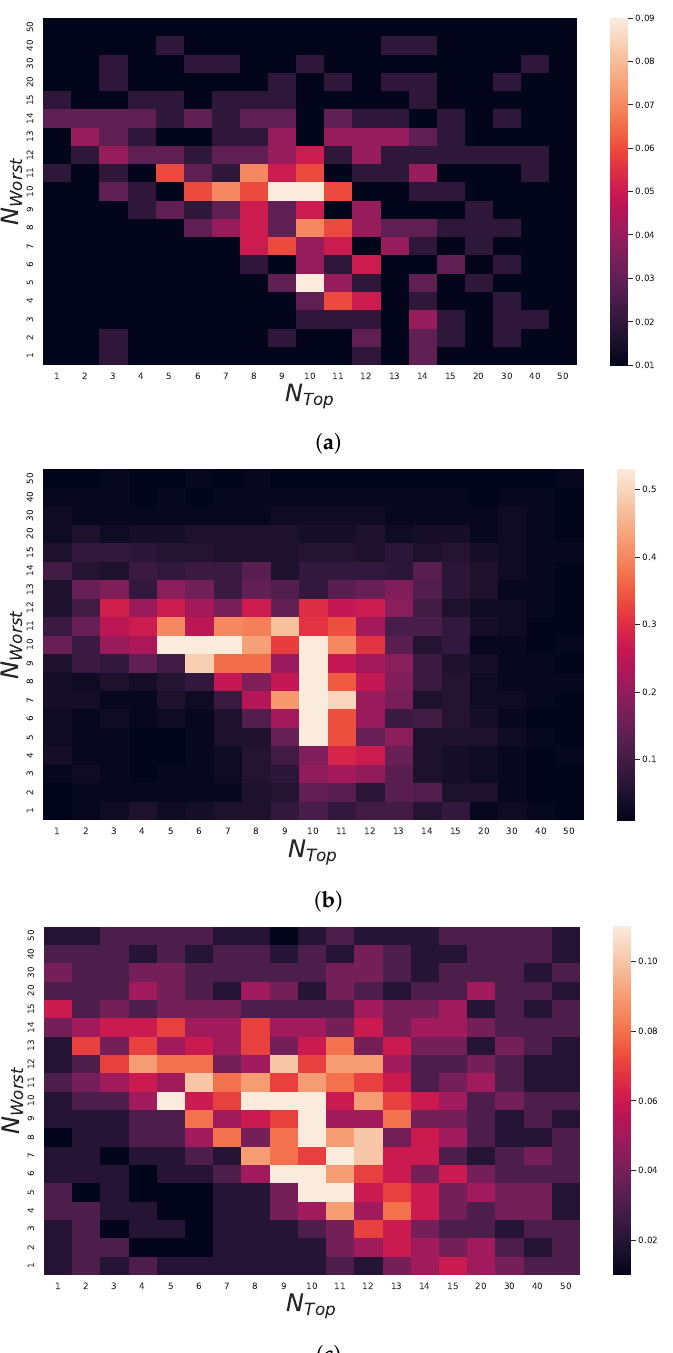
Figure 6. Experiments with respect to N Top and N Worst settings. In each heatmap, the aver- age enhancement values AvgImp ( N Top , N Worst ) for N Top and N Worst are varying in grid on set { 1,2,3,4,5,6,7,8,9,10,11,12,13,14,15,20,30,40,50 } . For the computation of these values, N run = 35 executions for each method were considered. ( a ) LA01. ( b ) LA21. ( c ) LA25. In this case, the best value, the worst value, the mean and the standard deviation (SD) of the makespan values calculated at 35 independent executions of each method on the eight JSSP instances considered are presented in Table 1. The number of times the